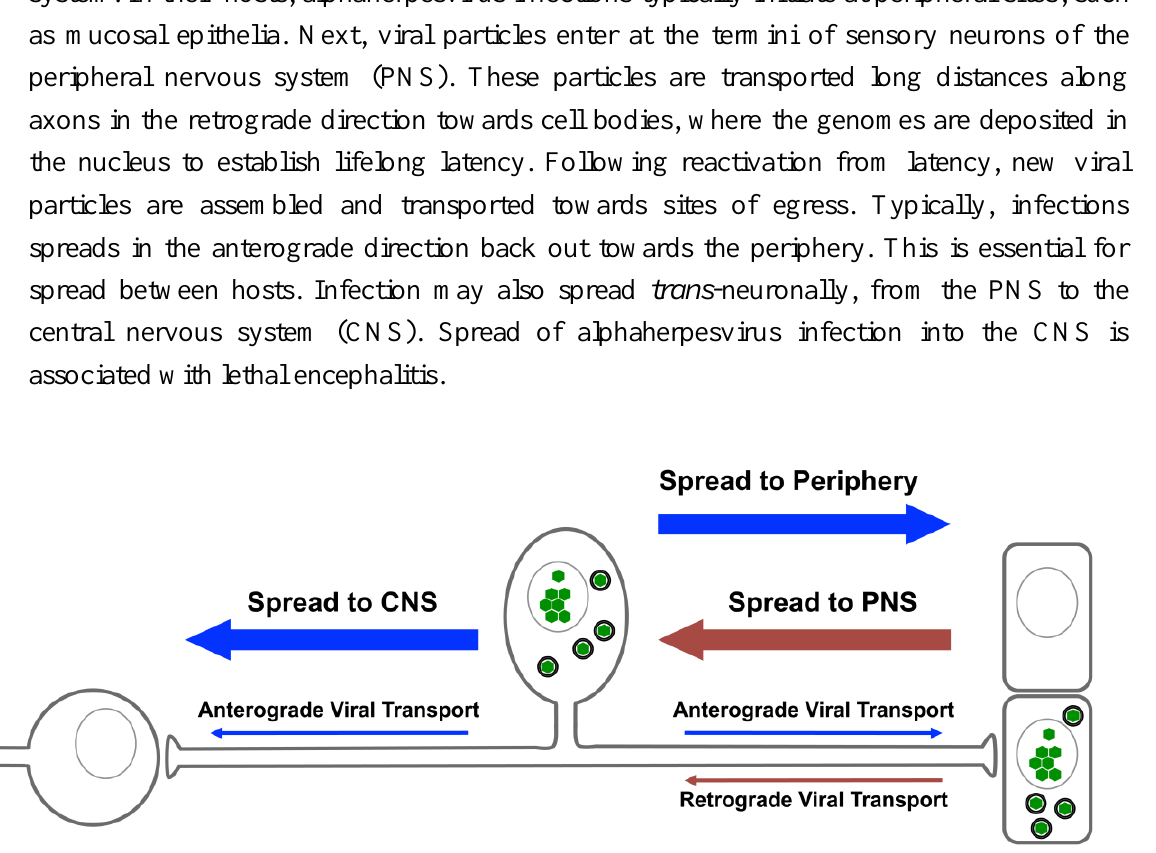
Figure 1. Directional spread of alphaherpesvirus infection in the mammalian